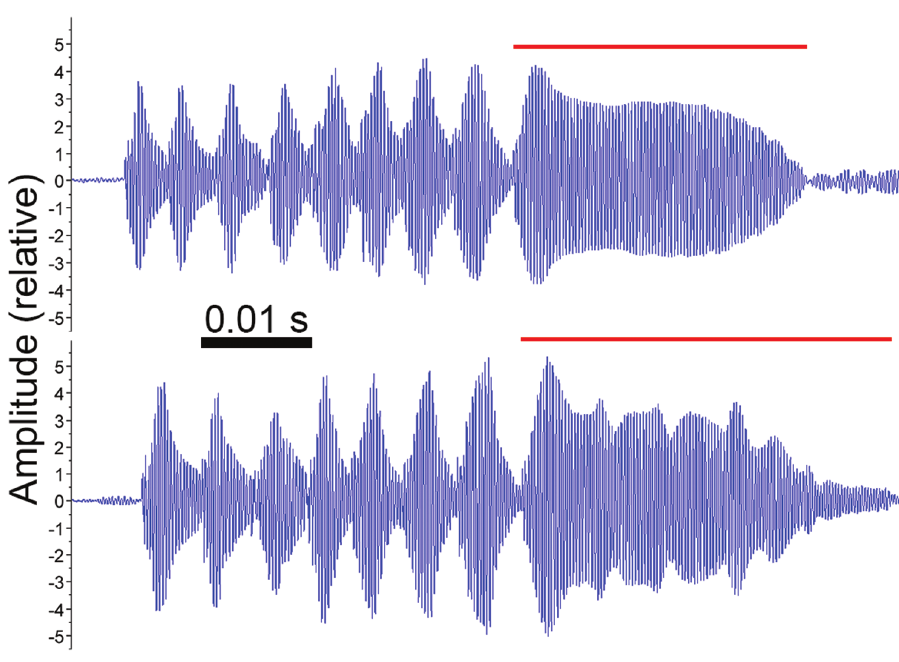
Figure 2. Calls of Boana latistriata from its type locality. Two examples of call A, emitted by the individual ZUFRJ 15077 (snout-vent length = 40.0 mm), showing the last pulses fused in a pulsatile (below the red